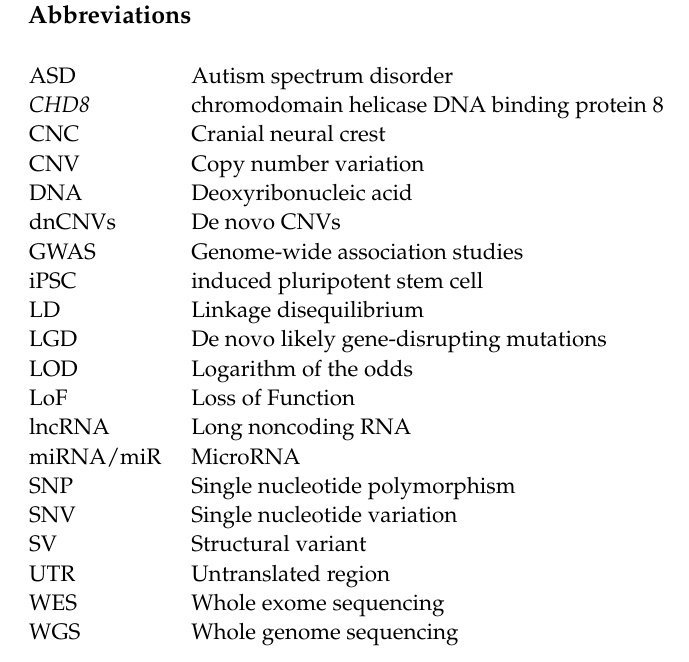
Supplementary Figure S1: Heatmap showing differential expression of miRs in ASD from various sample types (brain, blood lyphocytes, LCLs, serum and